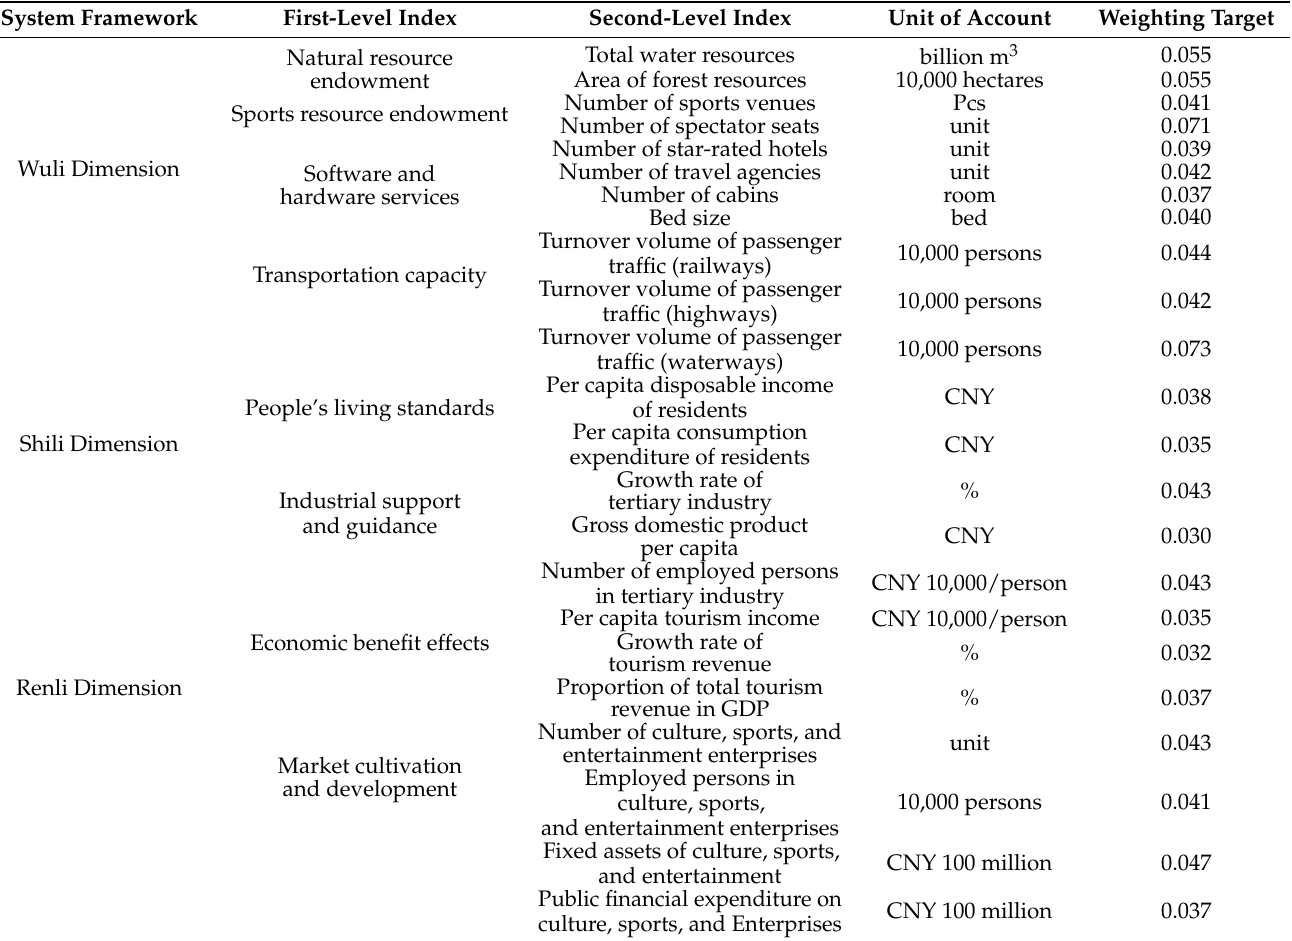
Table 1. Index selection of factors affecting sports tourism resources in